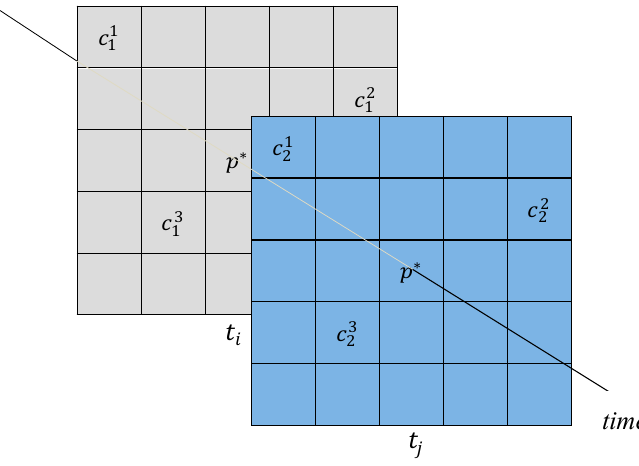
Figure 3. Framework of the dynamic selection.